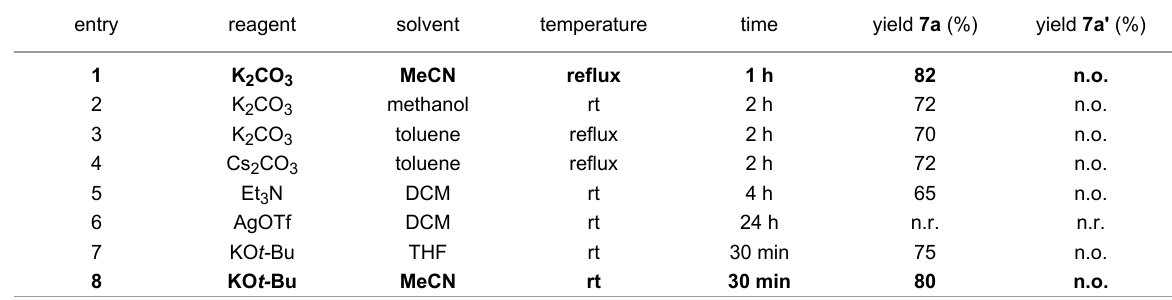
Table 1: Optimization conditions for the intramolecular cyclization (Scheme 3, 6 → 7a and 7a' ). a entry